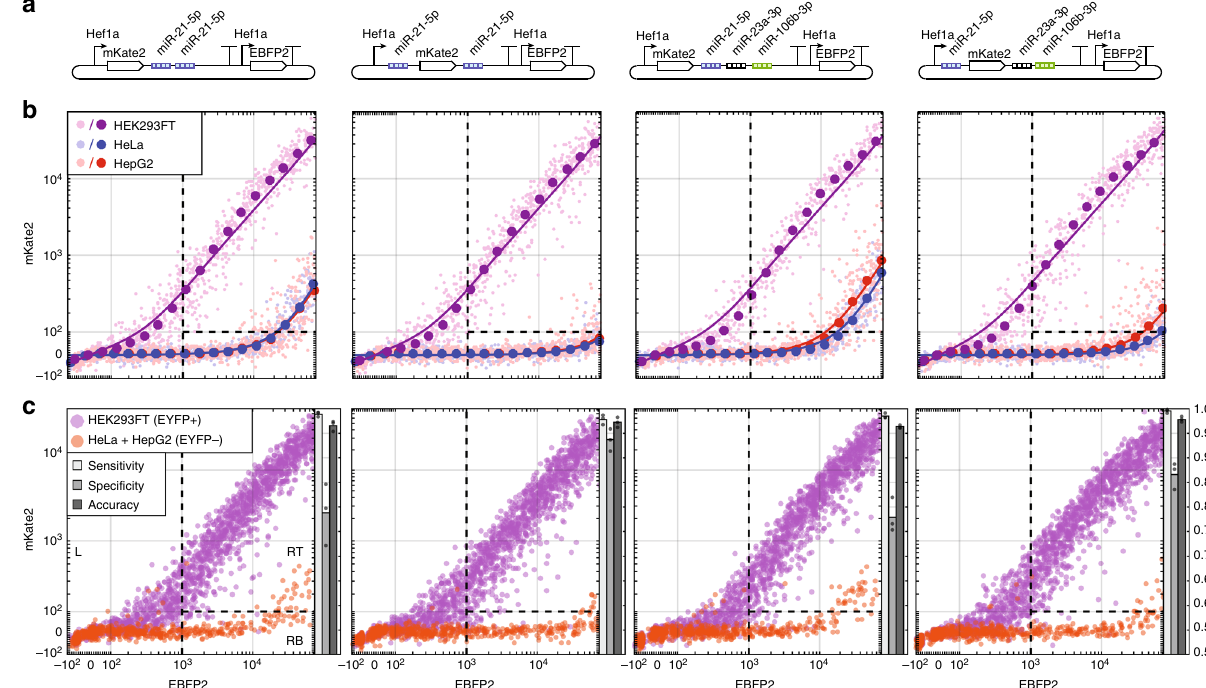
Fig. 6 miRNA target site position affects cell classi fi er performance substantially. a Circuit diagrams for miRNA classi fi ers to distinguish HEK293FT cells from HeLa and HepG2. Two pairs of classi fi ers were tested, some encoding miRNA targets only in the 3 ′ UTR and others with one set of miR-21-5p targets moved to the 5 ′ UTR. miRNAs exhibiting high activity in HeLa and HepG2 cells but not HEK293FT were selected for inclusion. b Fluorescence observed after separate transfections of the corresponding classi fi ers from a into HEK293FT, HeLa, and HepG2 cells. Expression of mKate2 reporter remained high in HEK293FT cells for all classi fi ers, but knockdown of mKate2 in HeLa and HepG2 was enhanced only when miR-21-5p targets were placed in the 5 ′ UTR (columns 2 and 4) compared to the 3 ′ UTR (columns 1 and 3). Subsampled raw data are indicated as light points and binned data/ fi ts are indicated as dark points/lines. Subsampling was performed to normalize the number of cells within each EBFP2 expression level bin in order to minimize effects of transfection ef fi ciency on sensitivity and speci fi city measurements. c Classi fi cation of three cells lines in co-culture format. HEK293FT cells with genomically integrated constitutive expression of EYFP were co-cultured with HeLa and HepG2. Transfections were performed in cell mixtures for each classi fi er. After fl ow cytometry, gating for EYFP + and EYFP − cells was used to determine whether each cell was HEK293FT or HeLa/HepG2 in origin. Dotted lines demarcate three regions used to determine whether cells were classi fi ed as HEK293FT (RT: right top), HeLa/HepG2 (RB: right bottom), or undetermined due to low transfection levels (L: left). Sensitivity or true positive rate is calculated using [RT + ]/([RT + ] + [RB + ]), speci fi city or true negative rate is calculated using [RB − ]/([RB − ] + [RT − ]), and accuracy is calculated using ([RT + ] + [RB − ])/([RT + ] + [RT − ] + [RB + ] + [RB − ]) where + and − denote EYFP + and EYFP − , respectively. Classi fi ers with separate target sites in 5 ′ and 3 ′ UTR were better able to distinguish different cell types by reducing off-target expression as indicated by greater speci fi city (>85%). Bar charts indicate means from three technical triplicates shown as black